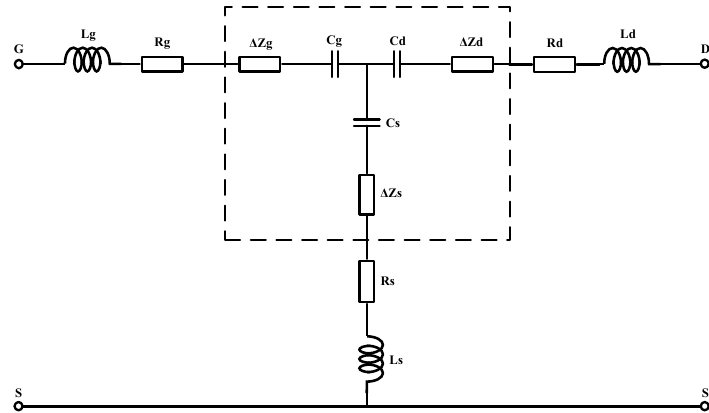
Figure 7. Simplified parasitic circuit model of GaN–reduced zero bias form (adapted from [31]).